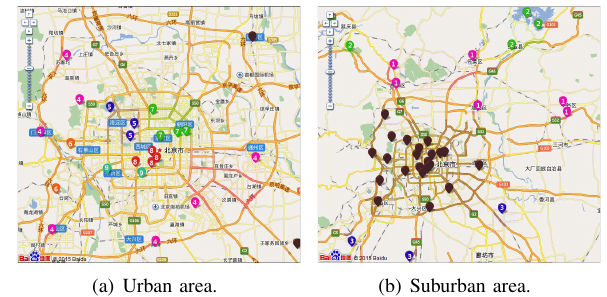
Fig. 6. Clustering results, counting frequency by II. B. 2). b), and clustering by k-means based on Affinity. Map provide by Baidu.com, Inc. -occurrence level respectively. These counts are treated as as f i and f j in equation (3).